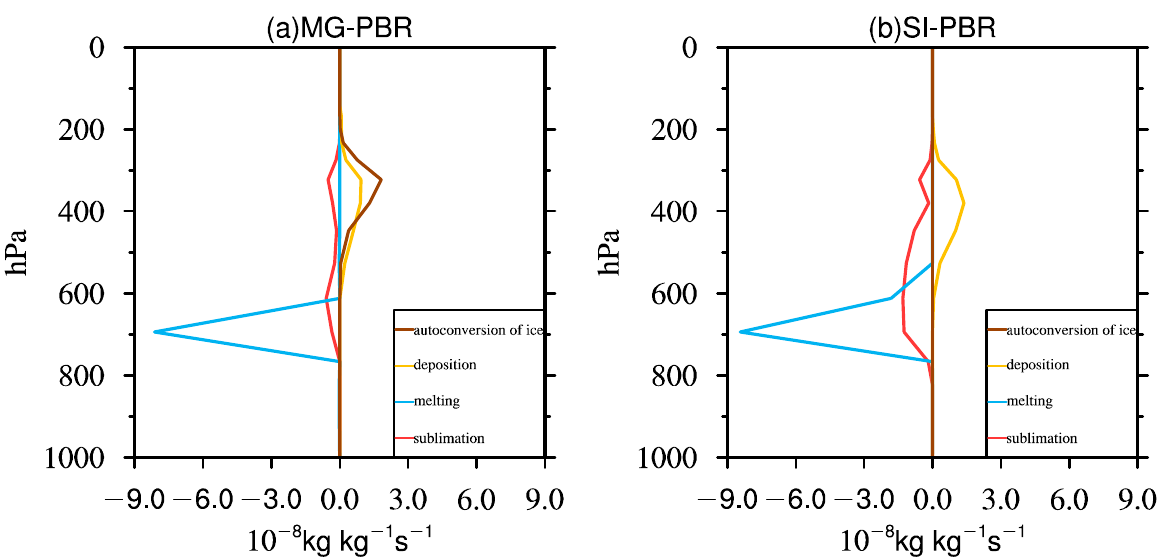
Figure 3. Vertical profiles of microphysics processes for ice in the MG–PBR and SI–PBR experiments, sublimation (red), melting (cyan), deposition (orange), and auto-conversion of cloud ice to snow (brown), respectively, averaged in the wet period.